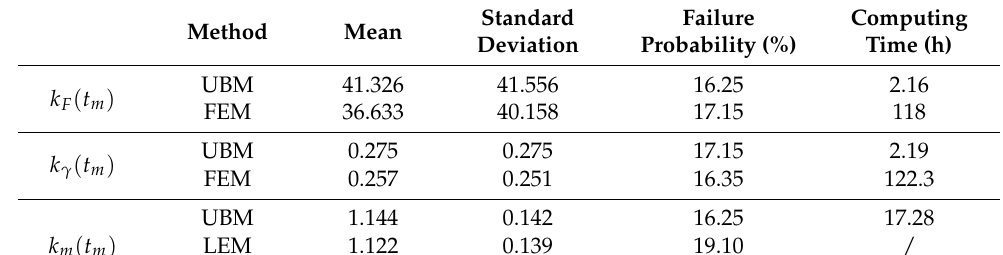
Table 6. Comparison of slope reliability results of different methods.